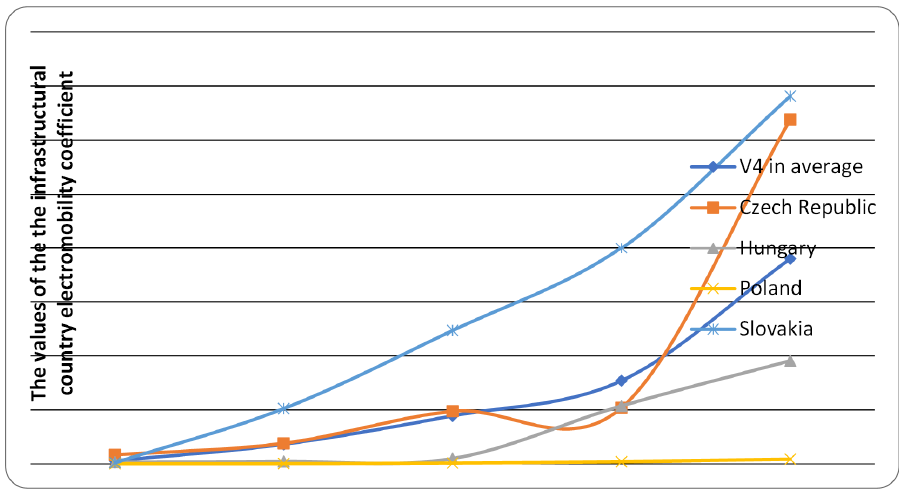
jumped up to a similar value as the Slovak one. It can be expected that governments’ ben- future, as well.